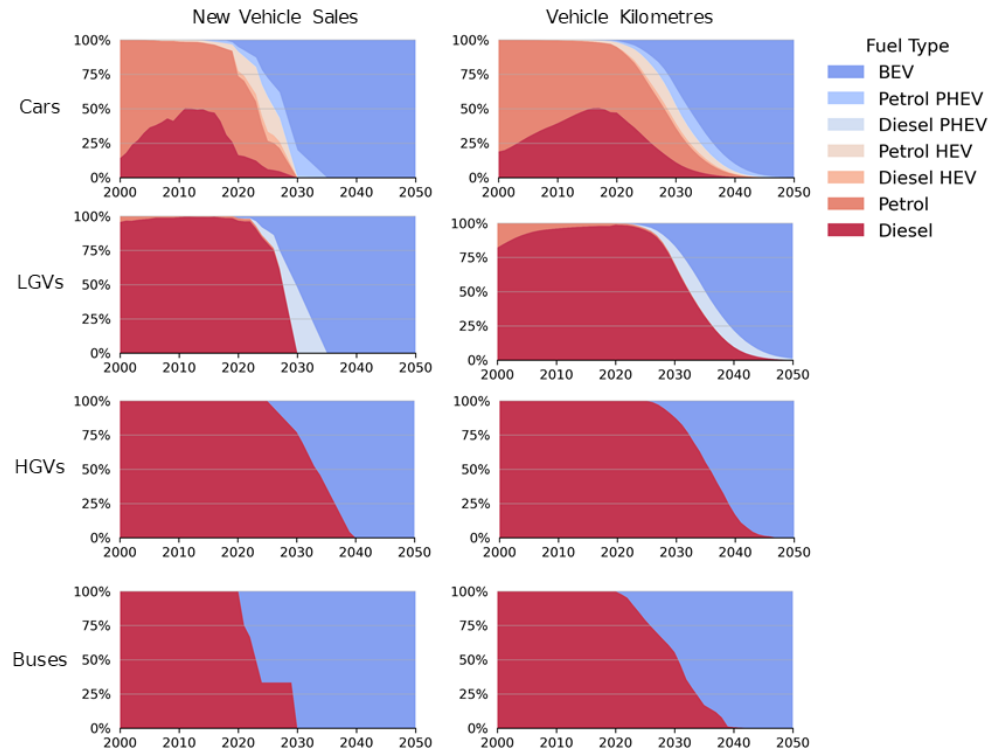
Figure 1. Left panels, the percentage of vehicle sales by fuel type for each year between 2000 and 2050 for the EV scenario. Right panels, the composition of vehicle kilometres driven for each fuel between 2000 and 2050, produced using the Fleet Turnover Model from Section 2.4, for the EV scenario. Table 1. Vehicle type fleet compositions for the year 2030; values represent the percentage of vkm broken down by the euro standard or fuel type for each vehicle type, for each scenario.